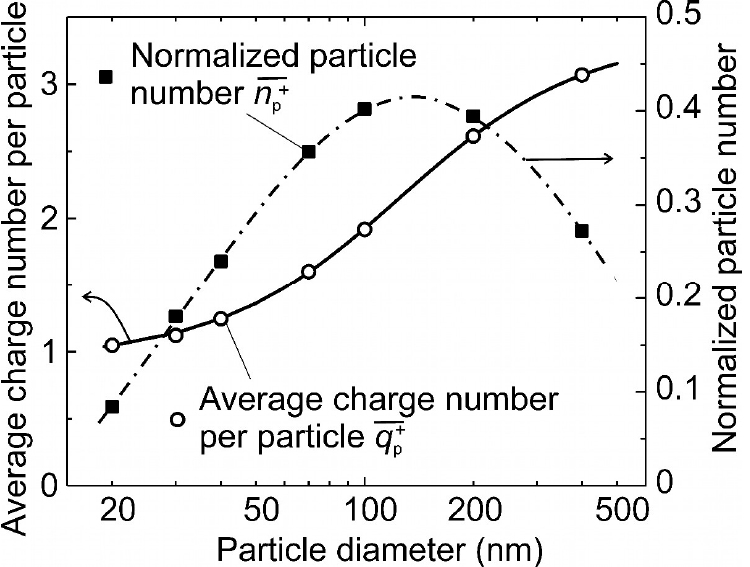
(cid:0) (cid:1) d p .